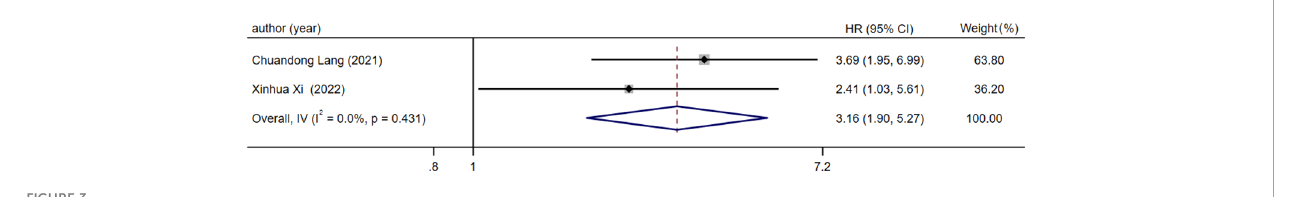
FIGURE 3 Forest plot of meta-analysis of the relationship between lncRNA expression and BMFS in prostate cancer patients with bone metastasis.